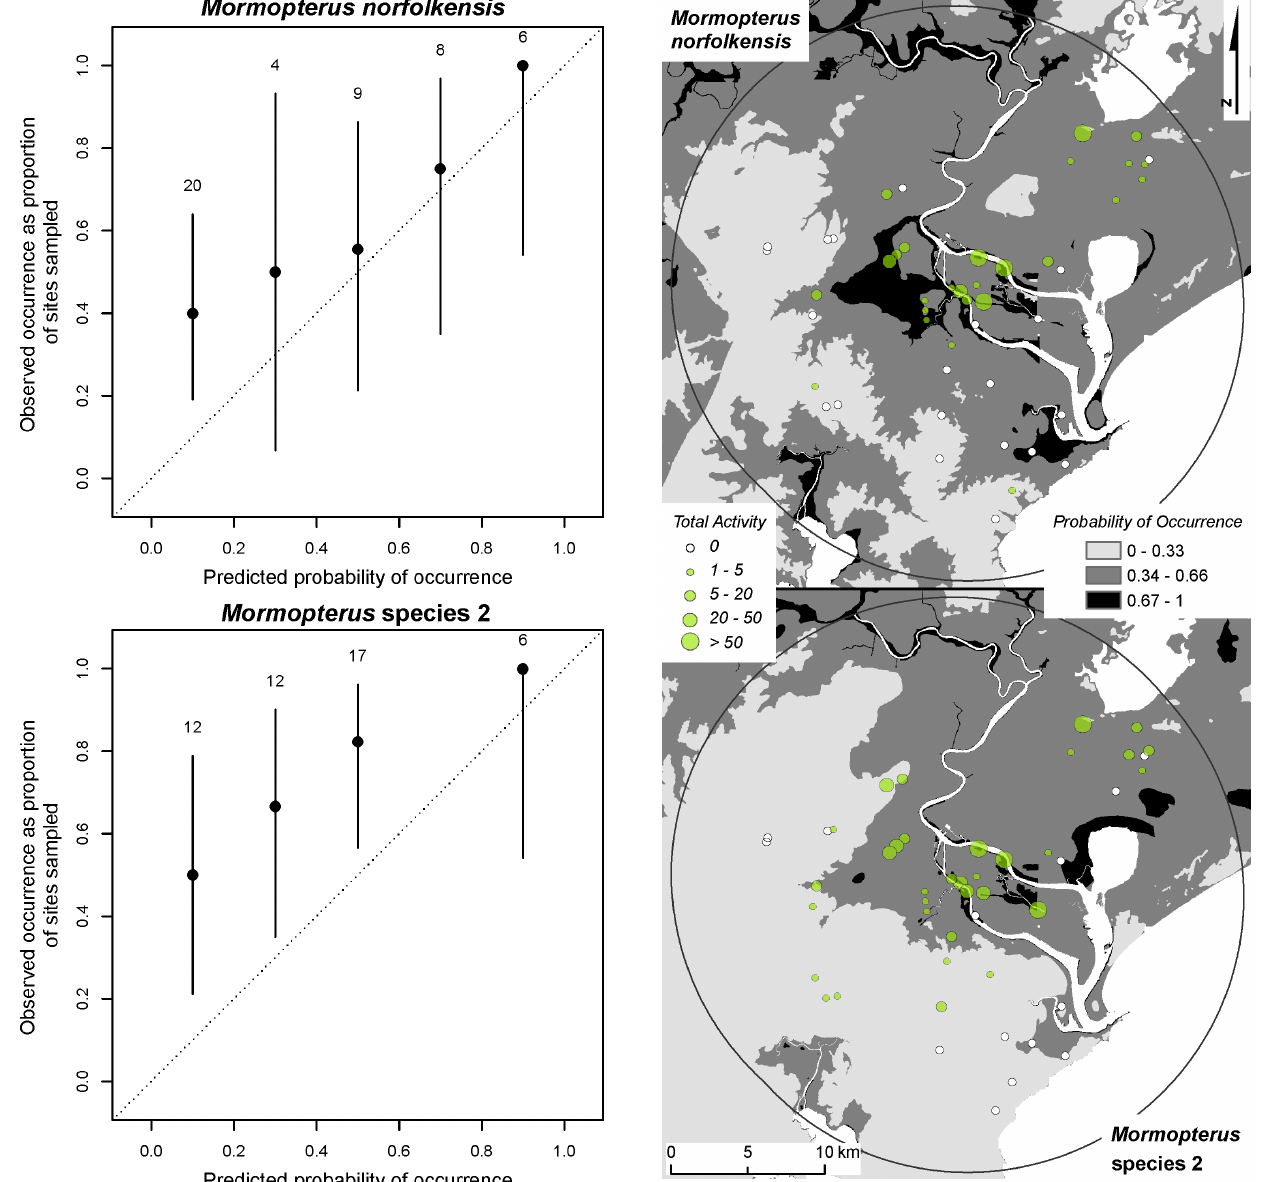
Figure 5. Regional model calibration plots. Calibration plots of the proportion of observed occurrence (collected during this study), against the predicted values of regional-scale probability of occurrence mapping [25] with 95% confidence intervals, for Mormopterus norfolk- ensis and Mormopterus species 2. Sample size in each bin is given by the numbers above. A close fit to the diagonal indicates good model calibration.